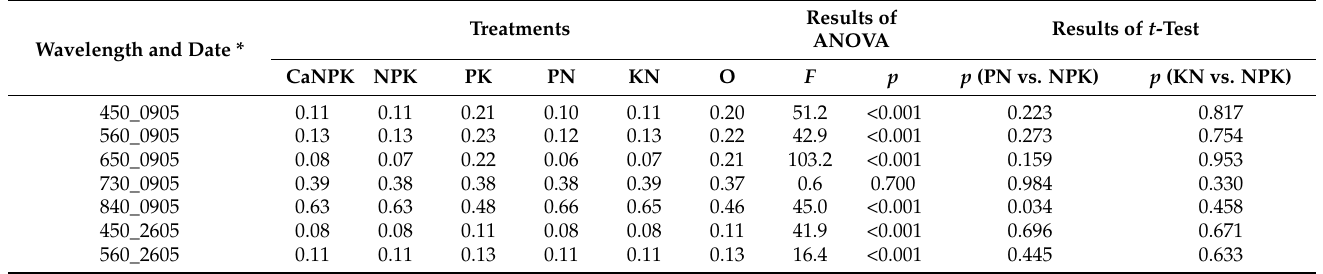
Figure 1. The design of long-term field experiments covered by the study together with the RGB map for 9 May 2022. 1—field experiment with crop rotation; 2—field experiment with monoculture of rye; 3—map of Europe presenting the location of the study (Skierniewice). Table 5. Means for relative spectral reflectance, soil pH and available nutrients, and grain yield for the treatments in experiment 1 (with crop rotation). Results of ANOVA and t -test for comparisons between the